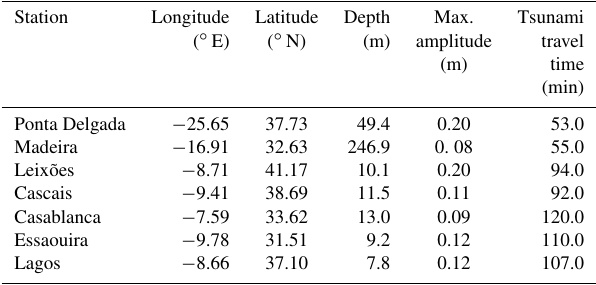
Table 1. POIs (points of interest) of the 1941 tsunami used in this study. Longitude, latitude and depth refer to the POI. POIs are named after the closest tide